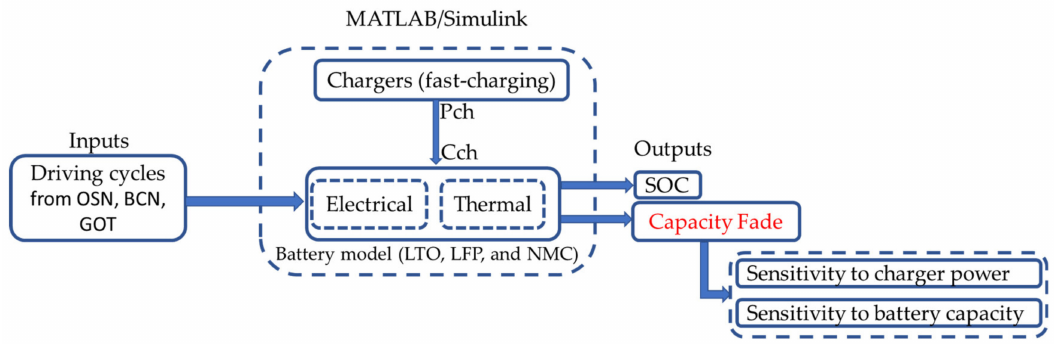
Figure 4. Analysis procedures of the battery’s capacity fade, P ch : charger power; C-rate (C ch